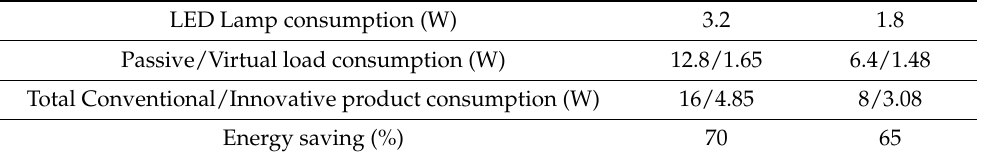
Table 1. Power consumption of the LED lamp, and the conventional and the innovative industrial product. Power saving level under both continuous and dynamic direction indicator